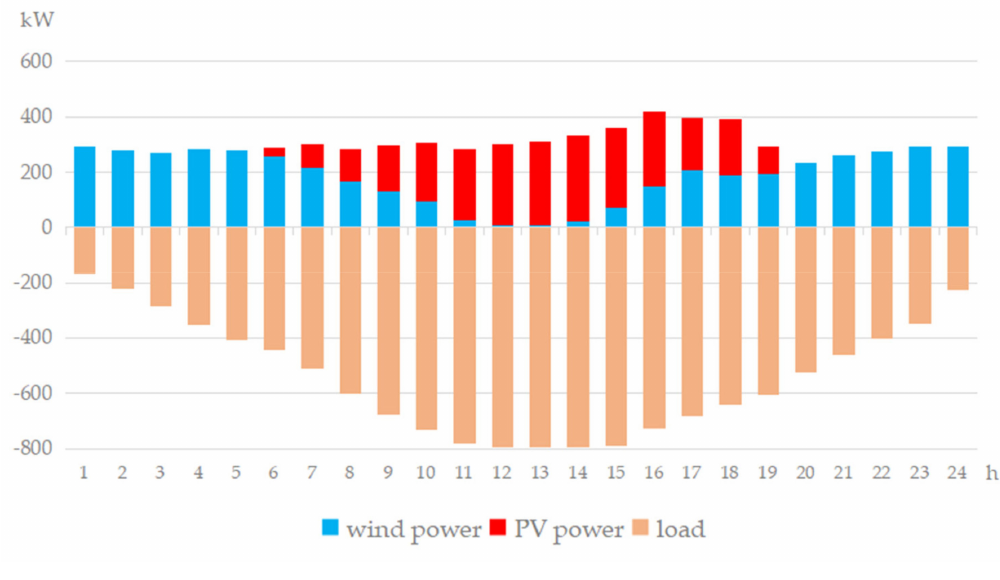
Figure 6. Supply-to-load curve of wind and PV power.